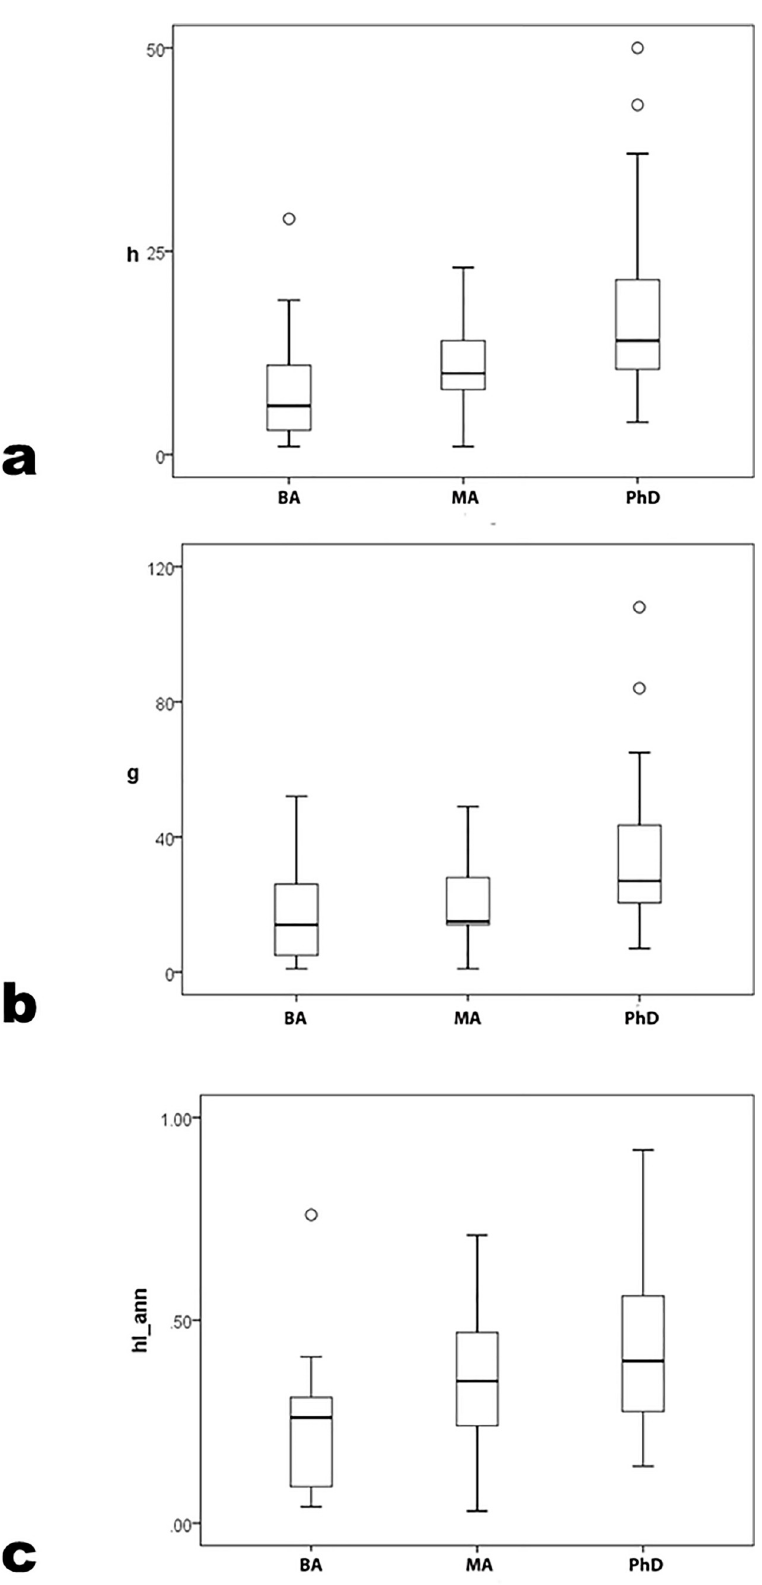
Fig 6. h , g and hIann by degree program for archaeologists who earned the PhD before